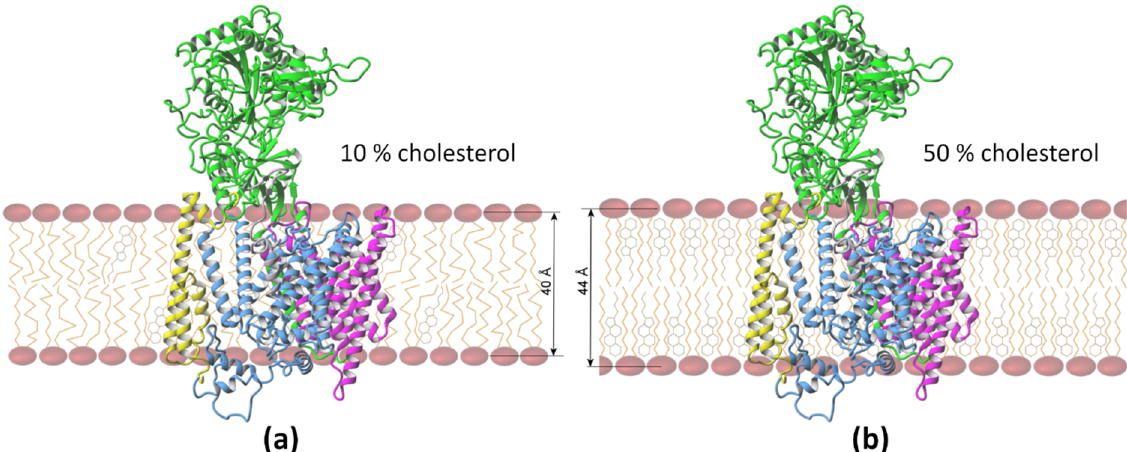
Figure 4. Position of the γ-secretase complex in the membrane and its average thickness taken from MD simulations. The same structure of the complex is shown in both panels for better visualization of its position. ( a ) The regular POPC membrane with 10% cholesterol and disordered lipid chains; ( b ) the raft-like bilayer with 50% cholesterol and nearly parallel lipid chains is on average 4 Å thicker.